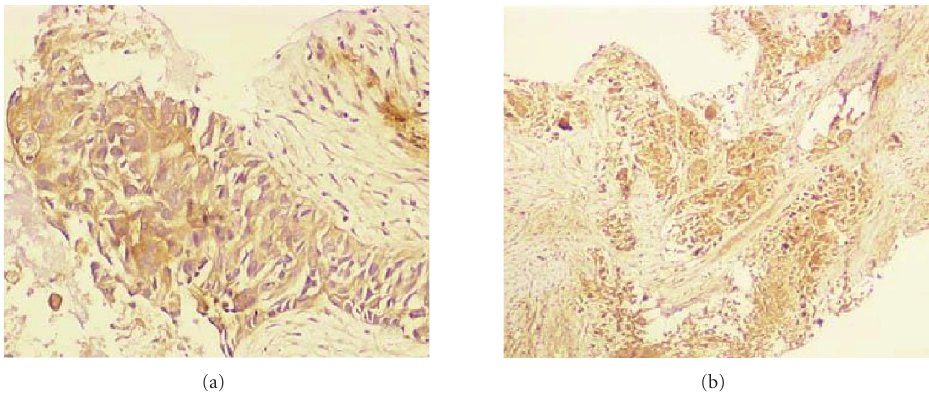
Figure 2: (a) Microscopic appearance of tumor cells showing di ff use and strong positive immunohistochemical staining for alpha fetoprotein. (b) Microscopic appearance of tumor cells showing di ff use and strong positive immunohistochemical staining for beta human chorionic